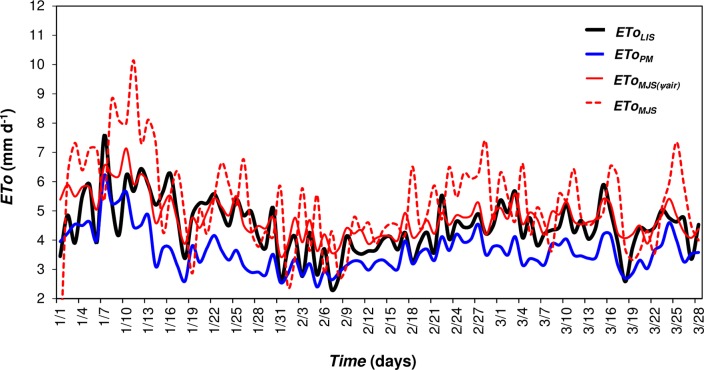
Daily EToLIS, EToPM, EToMJS(Ψair) and EToMJS for the semi-arid climate type Bsh, between 1997 and 1998 used as an in situ method of validation.